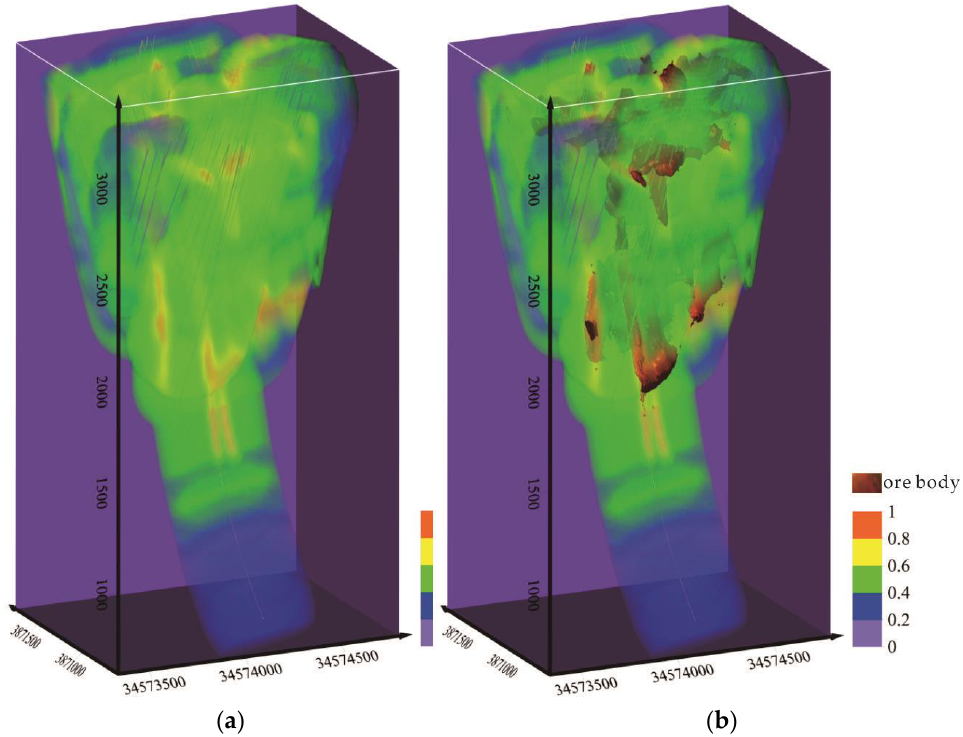
Figure 19. Three-dimensional MPM by MaxEnt model. ( a ) Three-dimensional MPM; ( b ) three-dimensional MPM with orebodies.